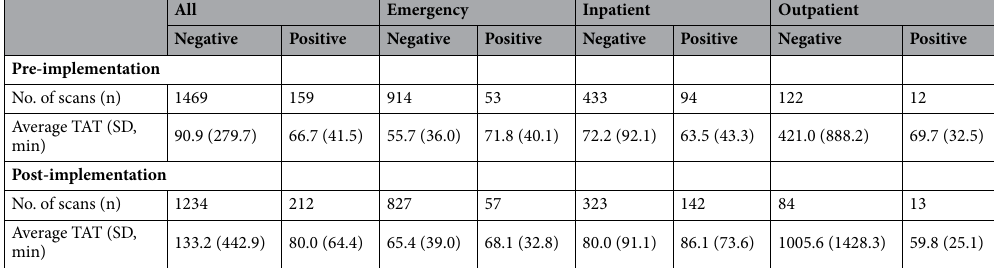
Table 2. Turn-Around-Time (TAT) for the pre- and post-implementation datasets stratified by patient location: emergency, inpatient and